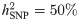
Theoretical predictions of power per causal SNP (upper panel) and out-of-sample R2 of the PGS (lower panel), for total sample size (x-axis) and cross-study genetic correlation (y-axis).Factor levels: 50 studies, 100k independent SNPs, and hSNP2=50% arising from a subset of 1k independent SNPs.